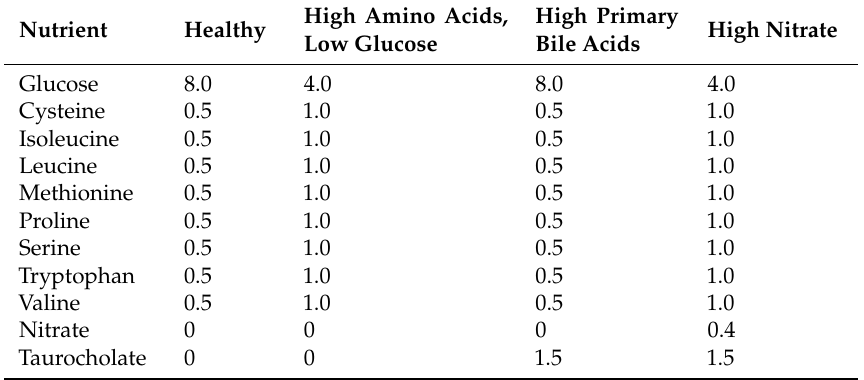
Table 1. Nutrient concentrations used for healthy and three dysbiosis simulation cases in